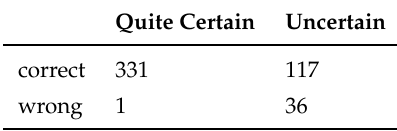
Table 8. Summary of network performance